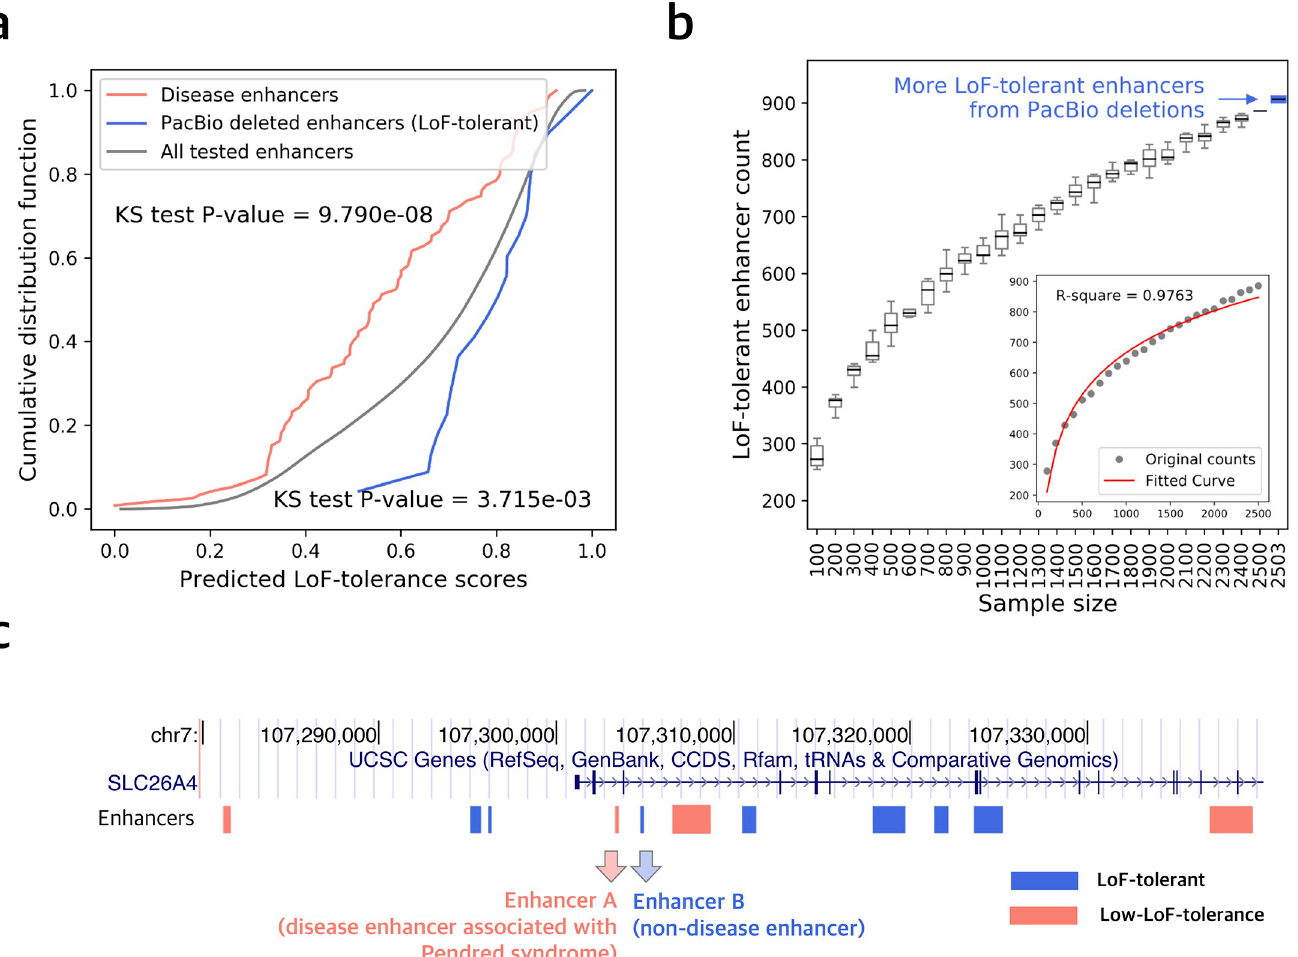
Fig 4. Validation using PacBio SVs and disease enhancers. a) Cumulative distribution function for LoF-tolerant scores for disease enhancers (red), all tested enhancers (grey), PacBio deleted enhancers (blue). KS-test P-values are between disease enhancers vs. all tested and PacBio enhancers vs. all tested. b) Number of observed LoF-tolerant enhancers with increasing sample size. On the x-axis, 2503 includes the LoF-tolerant enhancers observed from 3 additional individuals sequenced using PacBio. c) Genome region of SLC26A4 and part of the enhancers regulating it. Blue denotes the predicted LoF-tolerant enhancers, while red is for predicted low-LoF-tolerance